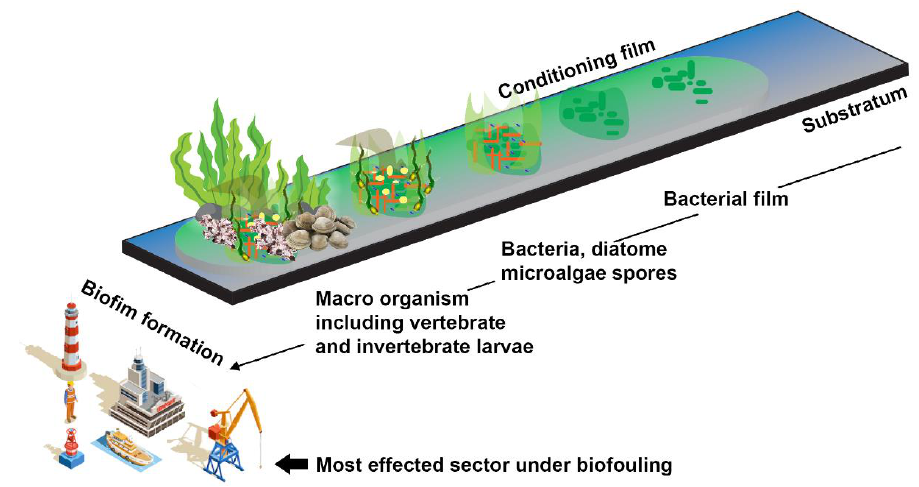
Figure 2. Major steps in biofilm formation may lead to biofouling events in the maritime sector. The biofouling started with the attachment of bacterial population on the object’s surface and was followed by the growth of other microorganisms, including diatoms, algae, and invertebrates. (Figure credit Freepik.com, accessed on 27 October 2022).